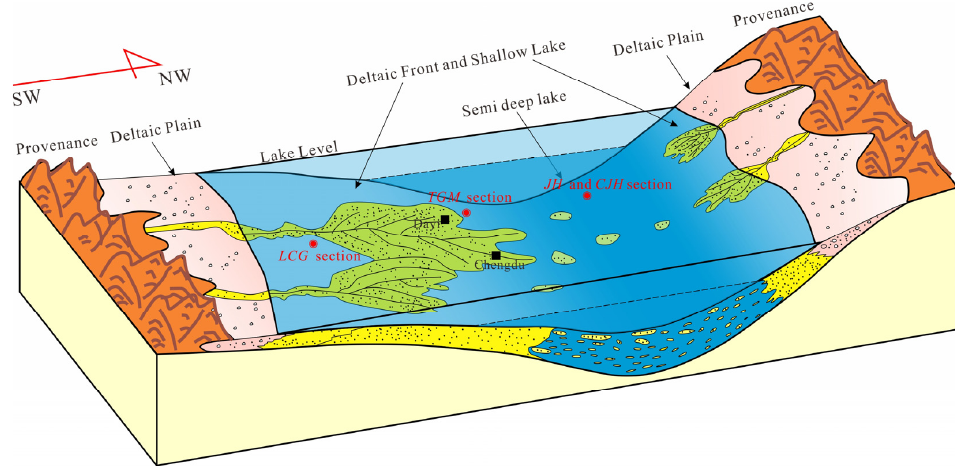
Figure 13. Depositional pattern of the Xu-3 Member in the Western Sichuan Depression, SW China.